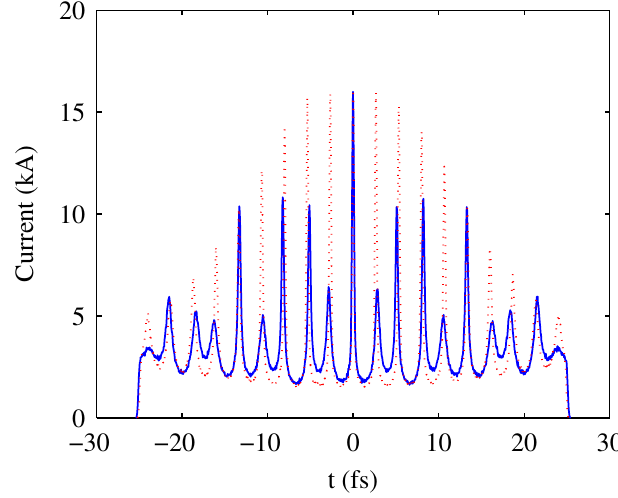
FIG. 2. (Color) Current profile after a bunching chicane. Solid blue curve is from the interaction with two optimized lasers, while the red dotted curve is from laser-1 only.